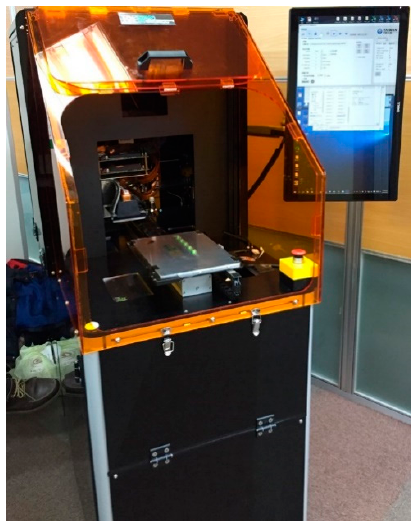
Figure 1. Homemade full-color material jetting (MJ) printer.